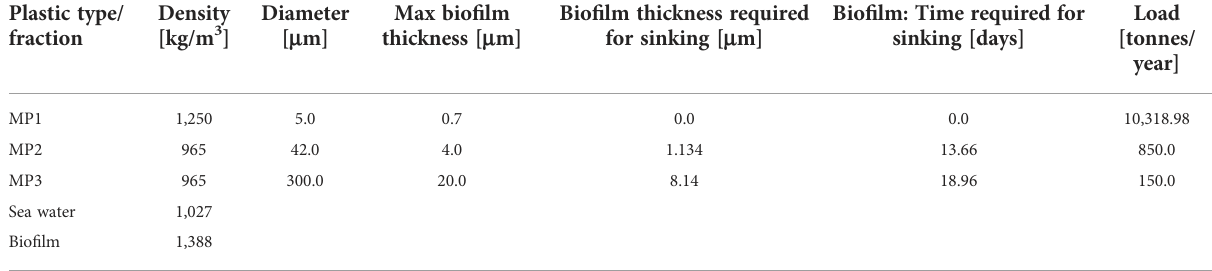
TABLE 1 Microplastic fractions, for tire wear microplastics MP1 and household microplastics MP2 – MP3 . Plastic type/